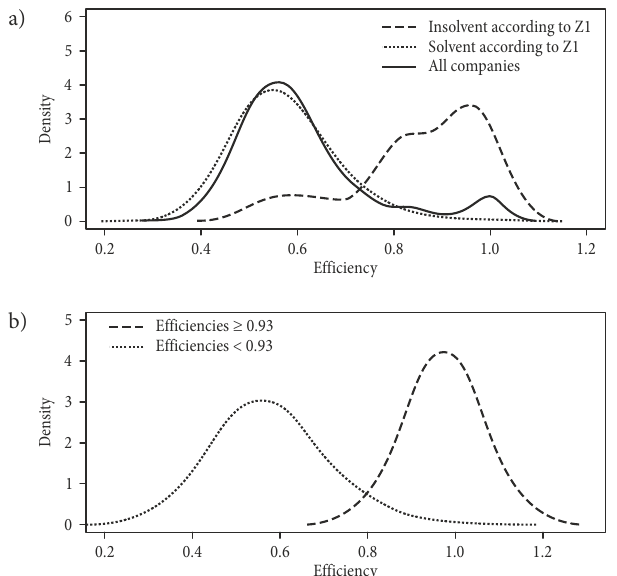
Fig. 1. Density comparisons between solvent and insolvent companies. Figure 1(a) shows the densities of the efficiencies according to Z criteria, while Figure 1(b) show the densities according to the cutoff 1 point of